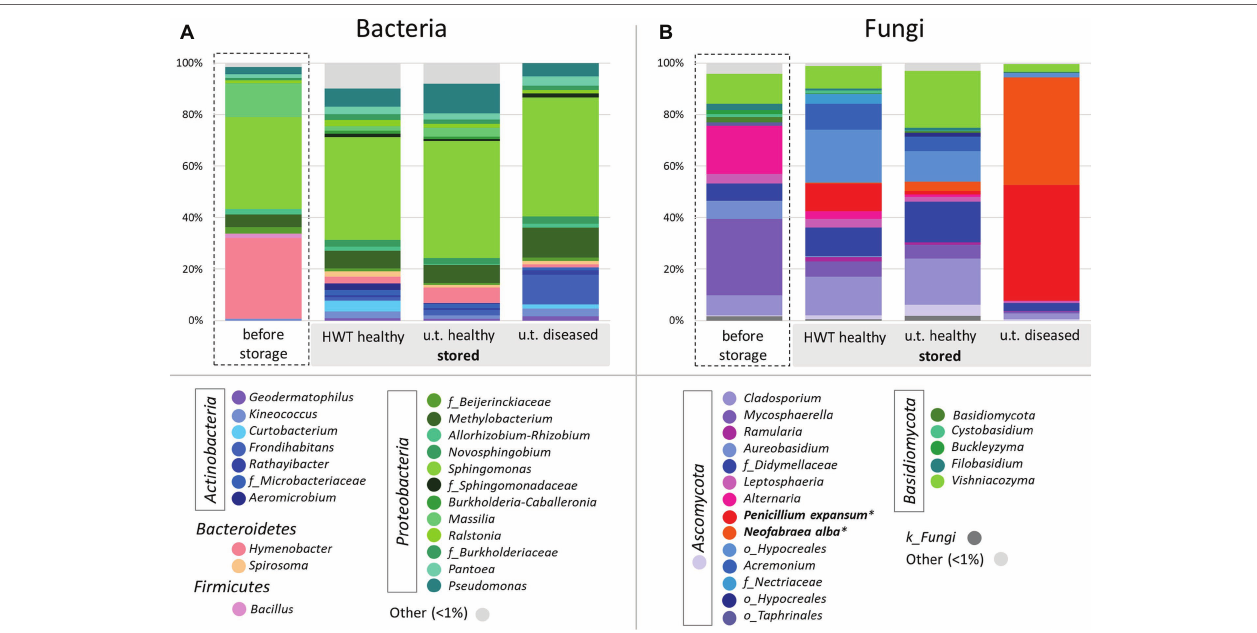
FIGURE 2 | Bacterial and fungal taxonomy of apples investigated. Core microbiomes were defined for taxa occurring in 50% of the replicates in the respective groups. Color-coded bacterial (A) and fungal (B) taxa are indicated in the bottom legend and are shown on genus level and grouped by phylum. Sequences of storage pathogens highlighted in bold were further identified on species level using NCBI BLAST alignment tool. Taxa occurring with less than 1% are shown as